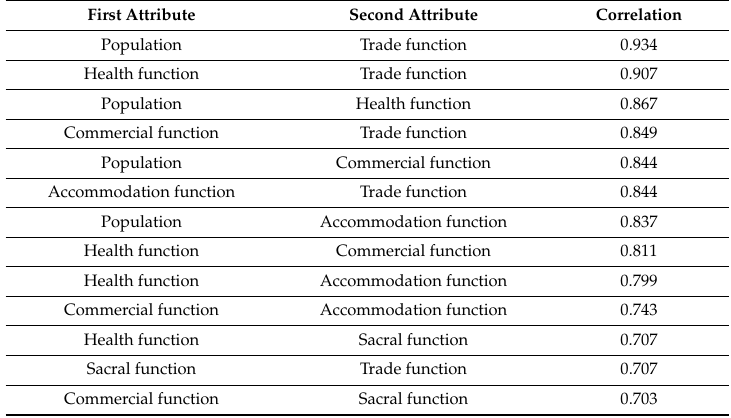
Table 4. Correlation value between the most correlated settlement attributes. Calculated for all four district